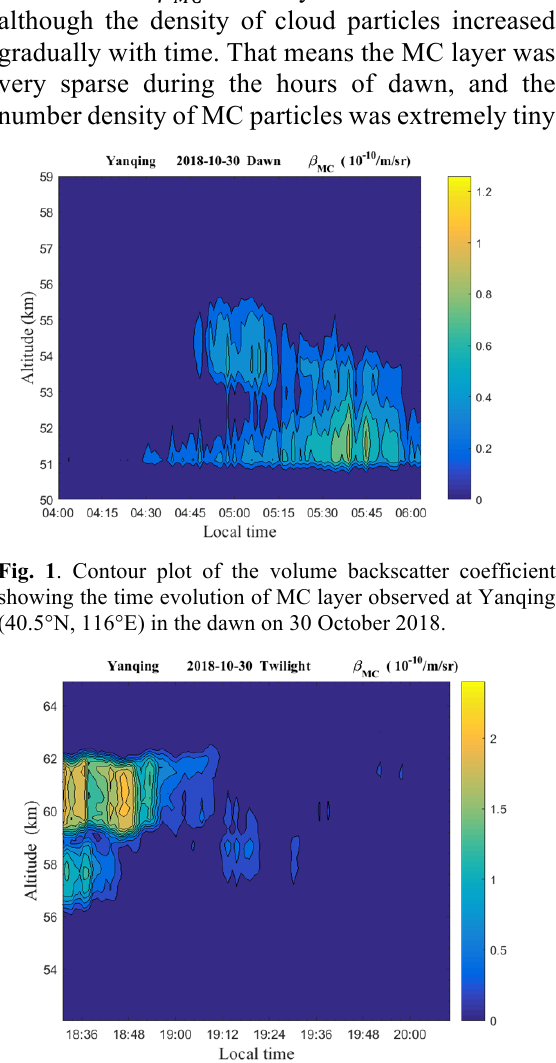
Fig.2 . Contour plot of the volume backscatter coefficient showing the time evolution of MC layer observed at Yanqing (40.5°N, 116°E) in the twilight on 30 October